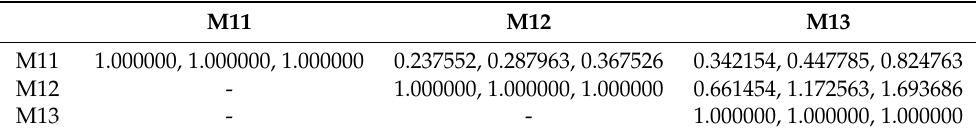
Table 5. Pair-wise fuzzy multi-criteria decision comparative matrix for types.